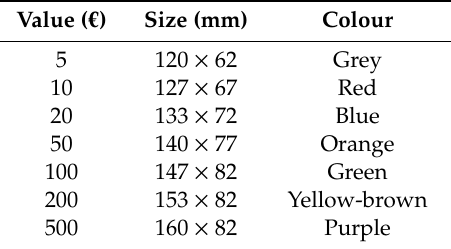
Table 2. Features of the Euro